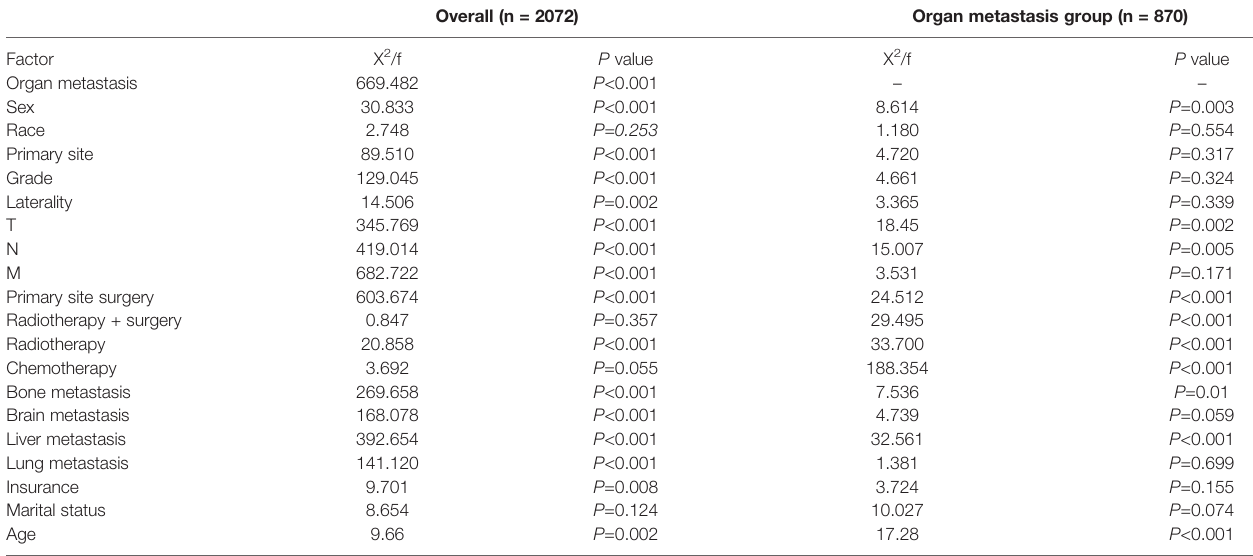
TABLE 3 | Univariate Cox analysis (overall and organ metastasis group).